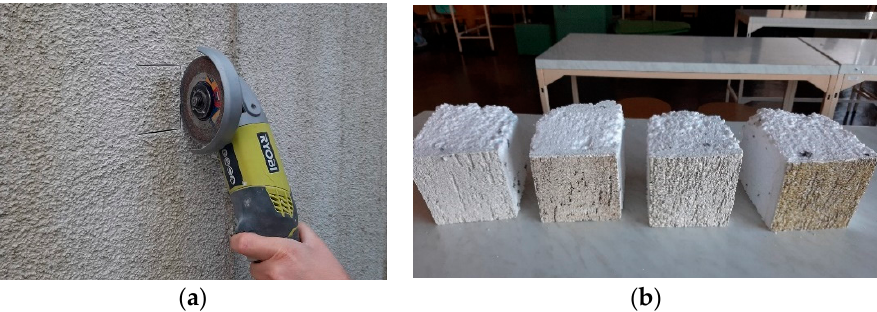
Figure 4. Sampling at the field site: ( a ) cutting the plaster surface; ( b ) samples that were cut out. After sampling, a fragment of Styrofoam was cut off, leaving a 2 cm thick layer. The type C samples prepared this way were dried to a constant weight at +40 ± 2 ◦